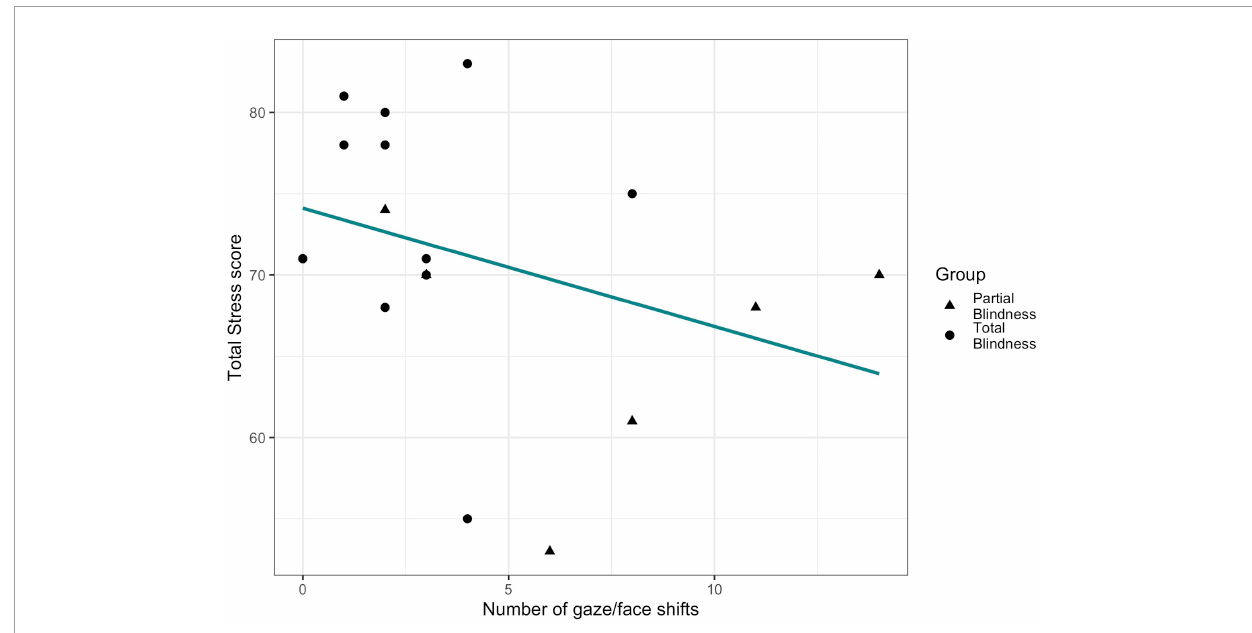
FIGURE4 Relationship between maternal stress and children’s gaze/face shifts during the coded 5 min of parents-child